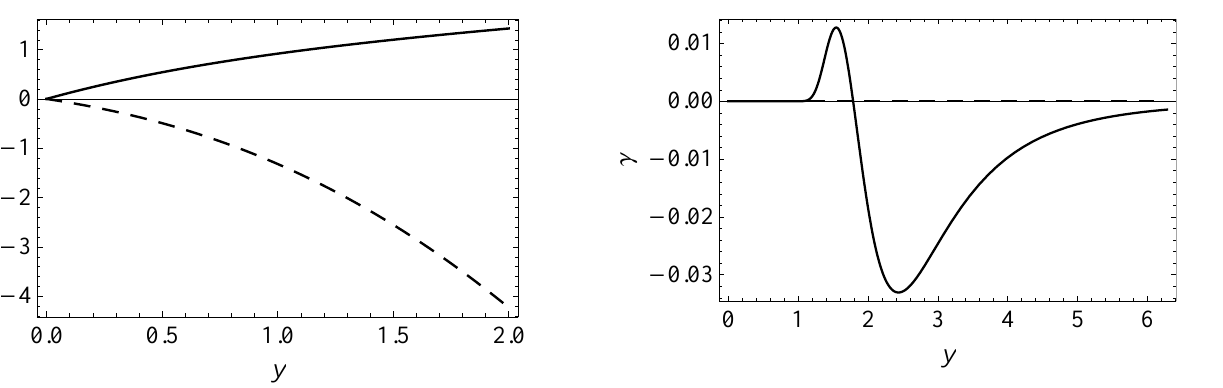
Fig. 2. Normalized growth rates of the two solutions of the disper- sion relation for β 2 ⊥ = 0 . 05 = 5 β 2 k ( A p = 4). Solid and dashed lines correspond to solid and dashed curves in Fig. 1,